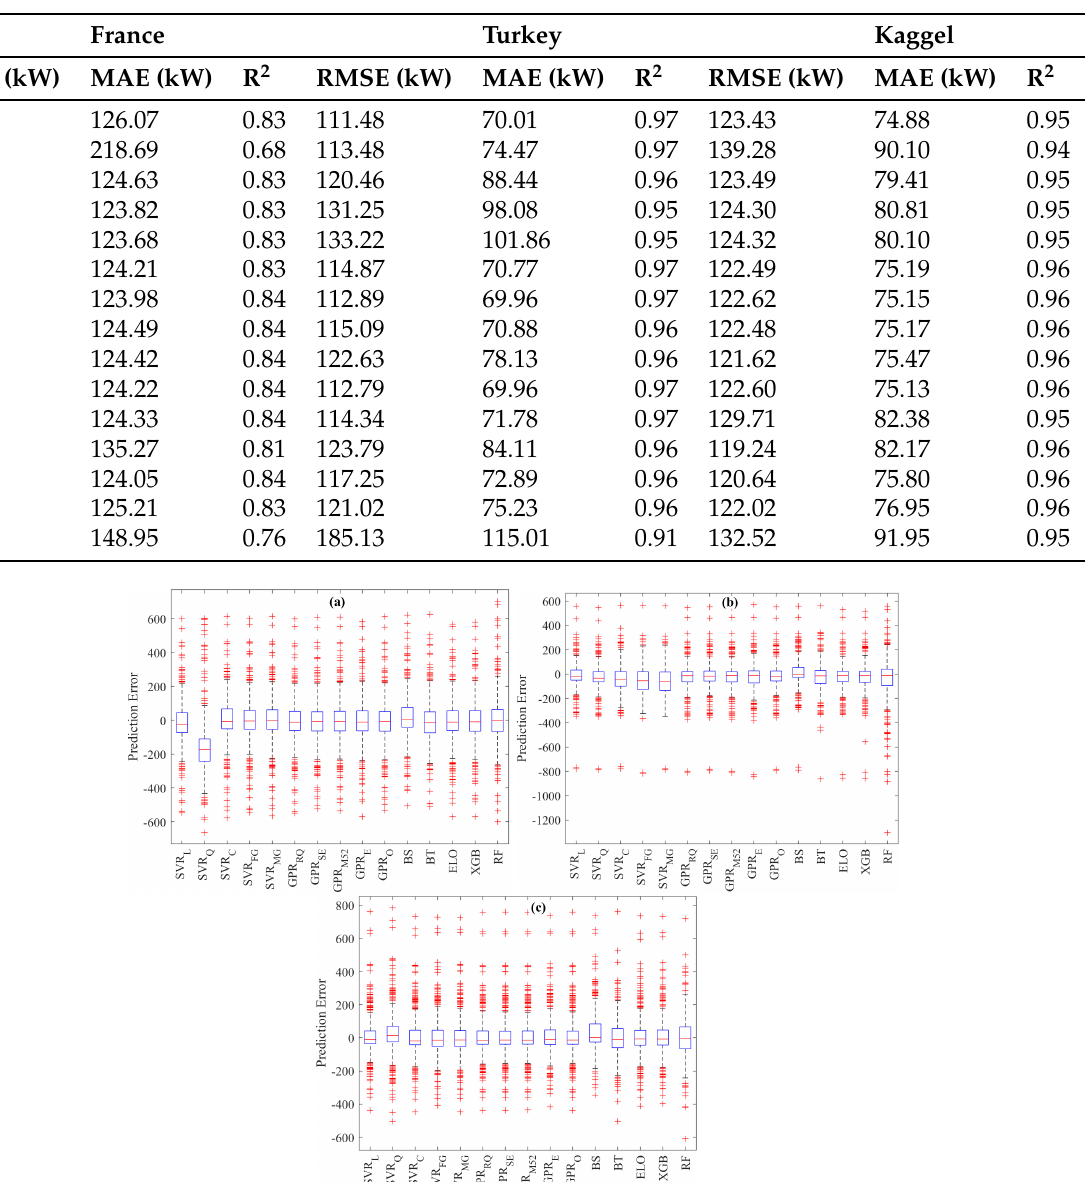
Table 2. Forecasting results using static models.